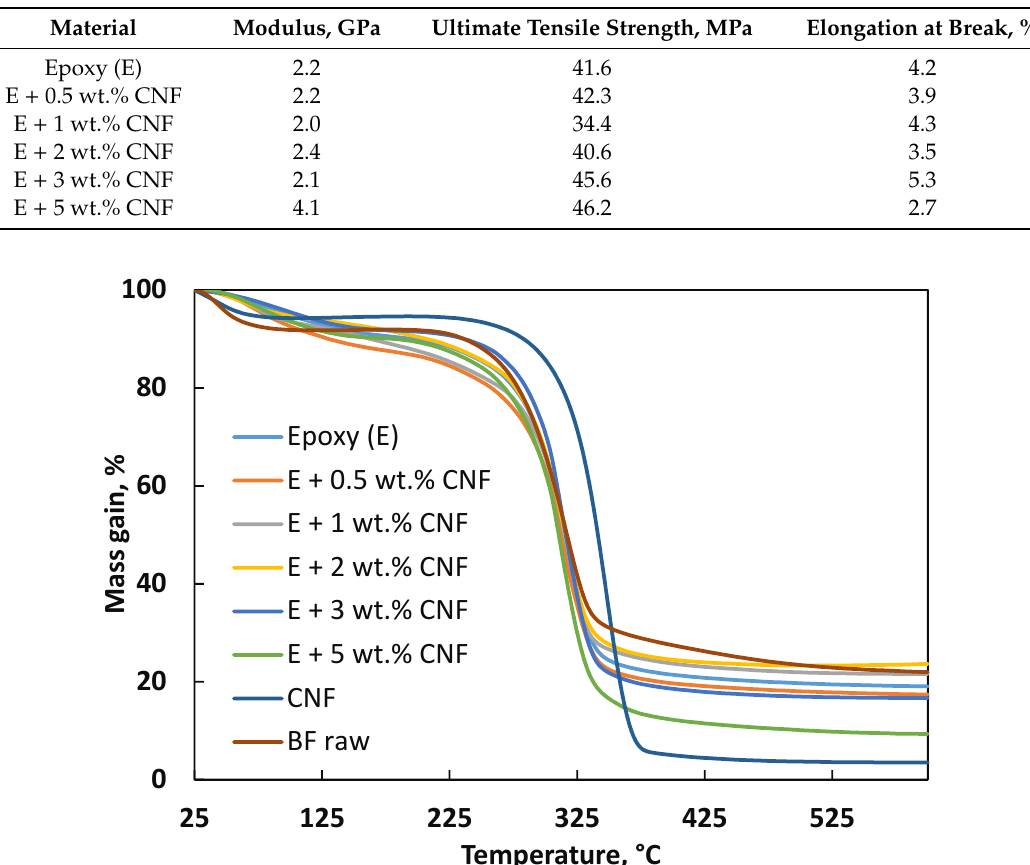
Figure 6. TGA curves of unfilled and CNF-filled epoxy nanocomposite series.